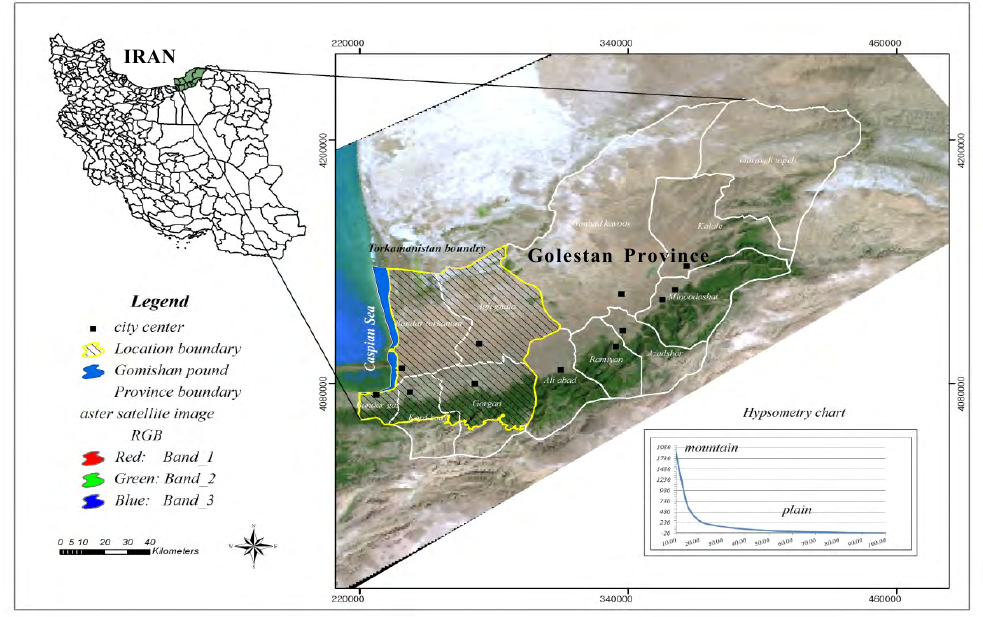
Fig. 2: Geographical location of the study area in Golestan Province, Iran Table 2: Scoring scheme for each index in the IMDPA model (Arami, 2012) Classes of Qualitative elements